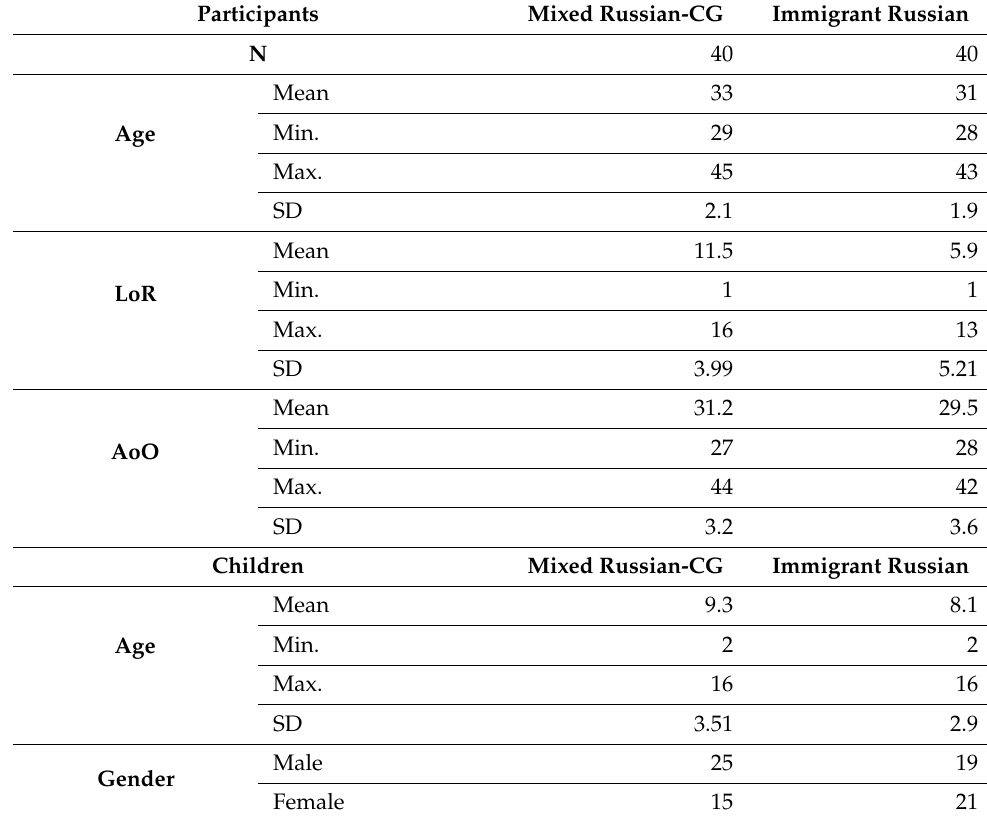
Table 1. Participants: background information.